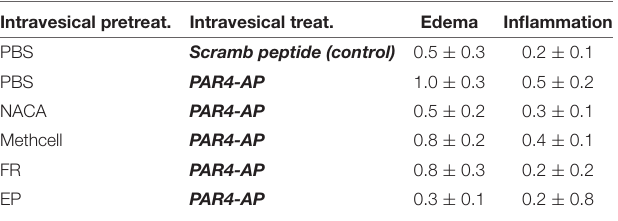
TABLE 3 | Effect of intravesical treatments on bladder histological changes. Mean ± SEM. N = 6 per group. Intravesical pretreat. Intravesical